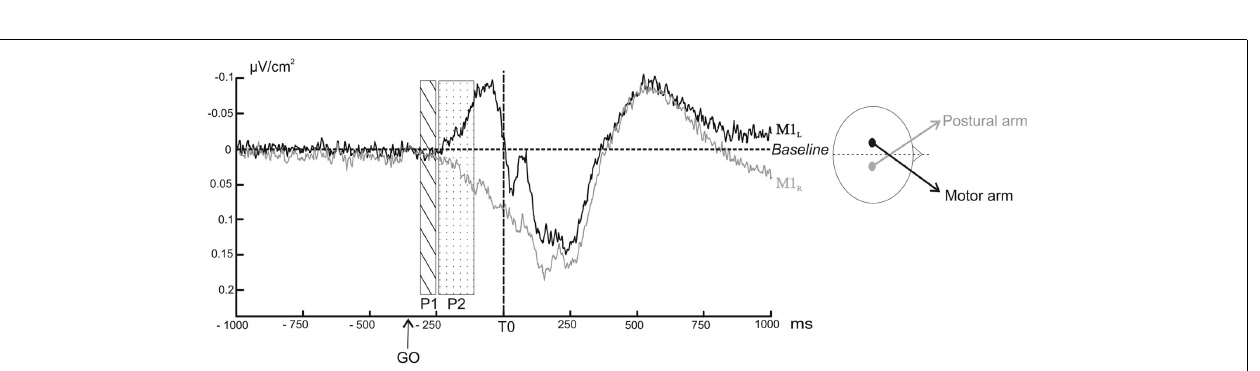
FIGURE 4 | Power profile in selected band power of theTF energy as a function of time over M1L (black line) and M1R (grey line) averaged across subjects. The arrows indicate the point at which the decrease in the selected band power became significantly different from the baseline